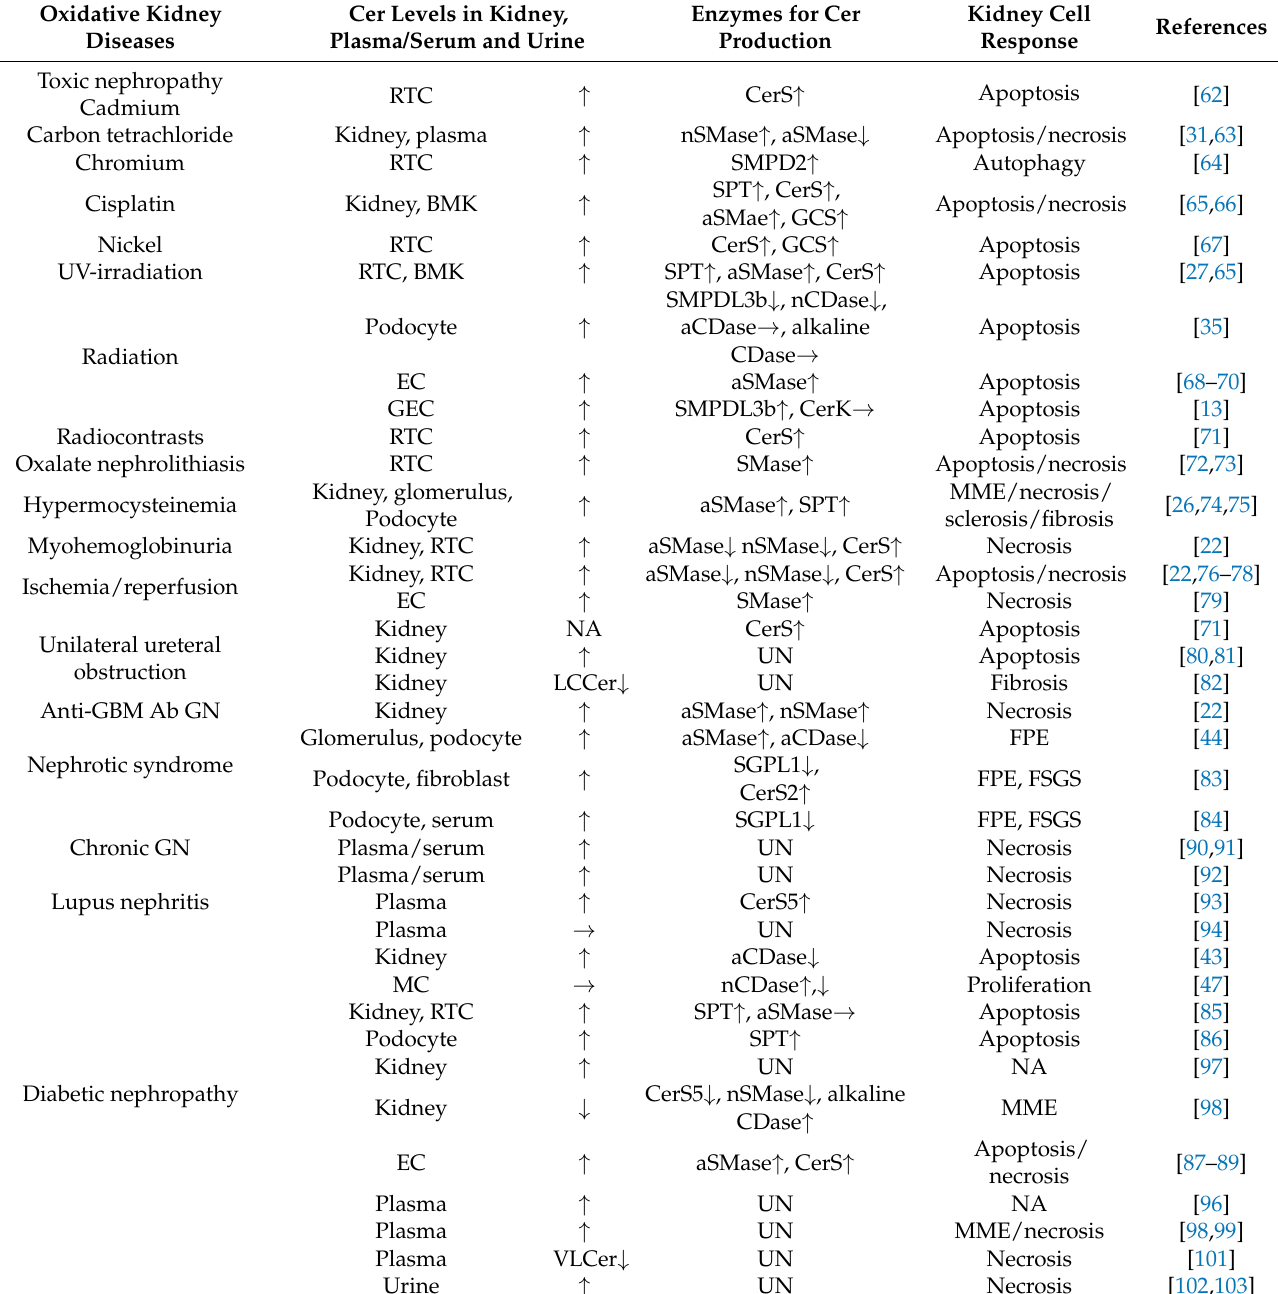
Table 2. Alteration of ceramide levels and kidney cell response in oxidant-induced kidney